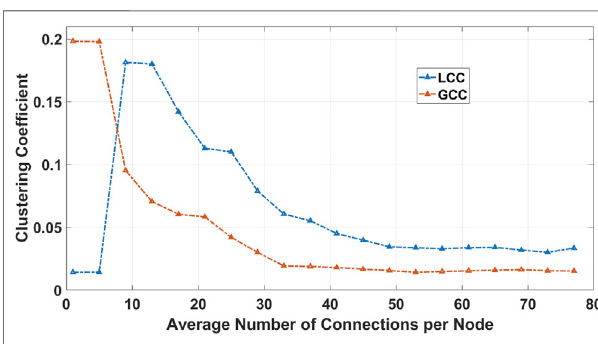
FIGURE 9| Local and global clustering coef fi cient of BA network for N = 10 000